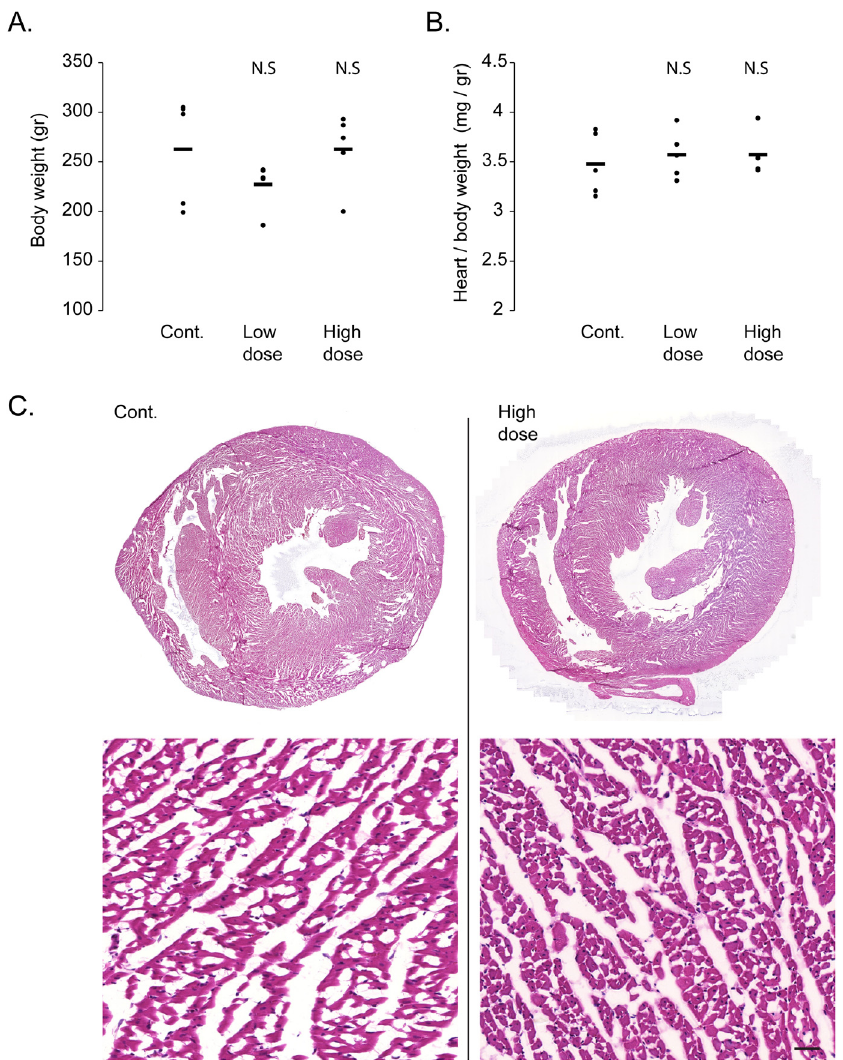
Figure 1. Rats injected with AAV9-cTnT-eGFP show no signs of toxicity. A . Gravimetric analysis show no difference in body weight between rats injected with ‘high dose’ or ‘low dose’ AAV9-cTnT-eGFP and control saline injected rats. Black bars show average and each dot represent a measurement from one rat. N.S = not statistically significant from control by Student t-test. B . Gravimetric analysis shows no difference in heart weight normalized to body weight between rats injected with ‘high dose’ or ‘low dose’ AAV9-cTnT-eGFP and control saline injected rats. Black bars show average and each dot represent a measurement from one rat. N.S = not statistically significant from control by Student t-test. C . Representative hematoxylin & eosin stained cardiac sections at low (top) and high (bottom) magnification, showing normal histology with no foci of necrosis or inflammatory cell infiltrates even in rats injected with ‘high dose’ AAV9-cTnT-eGFP (right). Control Saline injected rat heart is shown on the left. Bar = 100